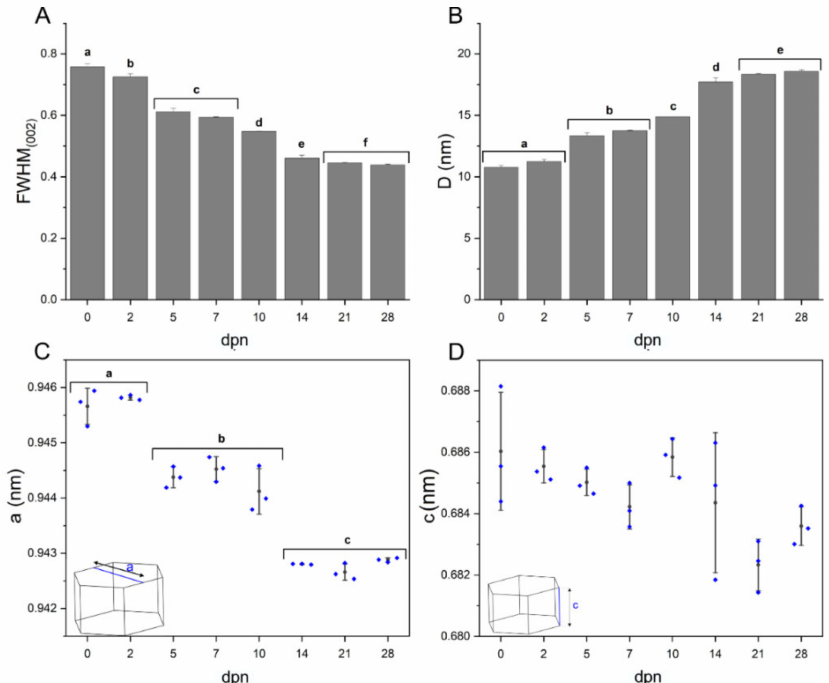
Figure 6. FWHM of (002) reflection peak ( A ), the mean size of HA crystallites in z crystallographic direction ( B ), lattice parameters: a ( C ) and c ( D ) calculated according to the age with corresponding standard deviations. Different letters indicate significant differences in groups (at p <